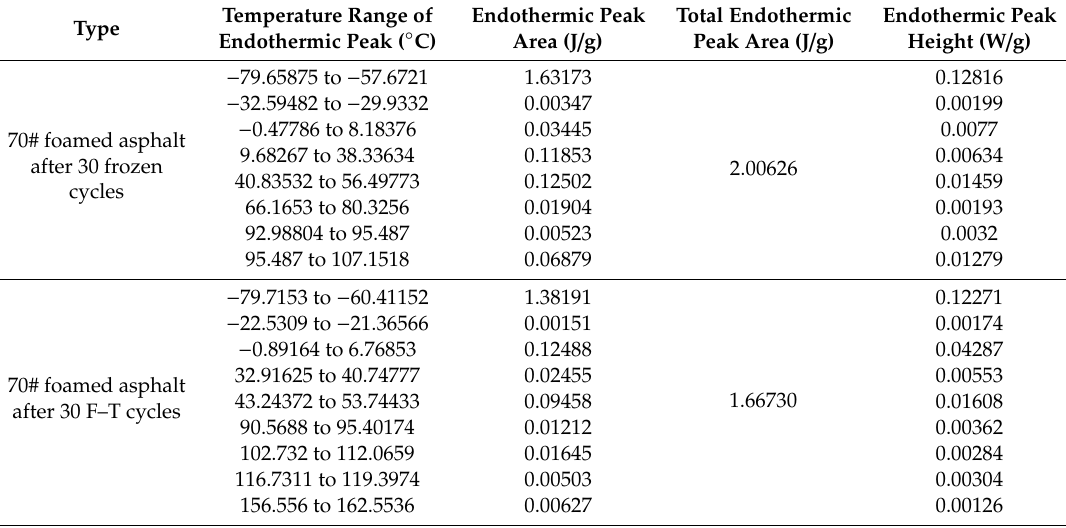
Table 5. The endothermic peak data of foamed asphalt with 30 frozen cycles and foamed asphalt with 30 F–T cycles.